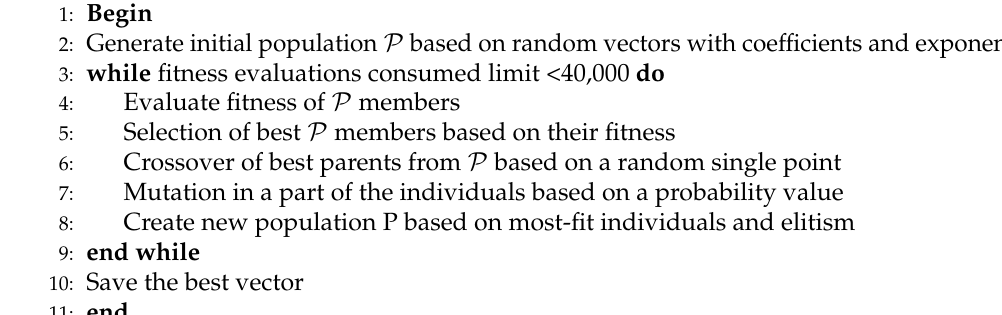
Algorithm 1 Genetic algorithm with elitism